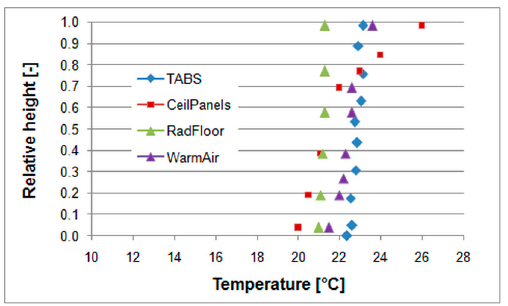
Figure 18. Air temperature profiles for different heating systems [80] and TABS.